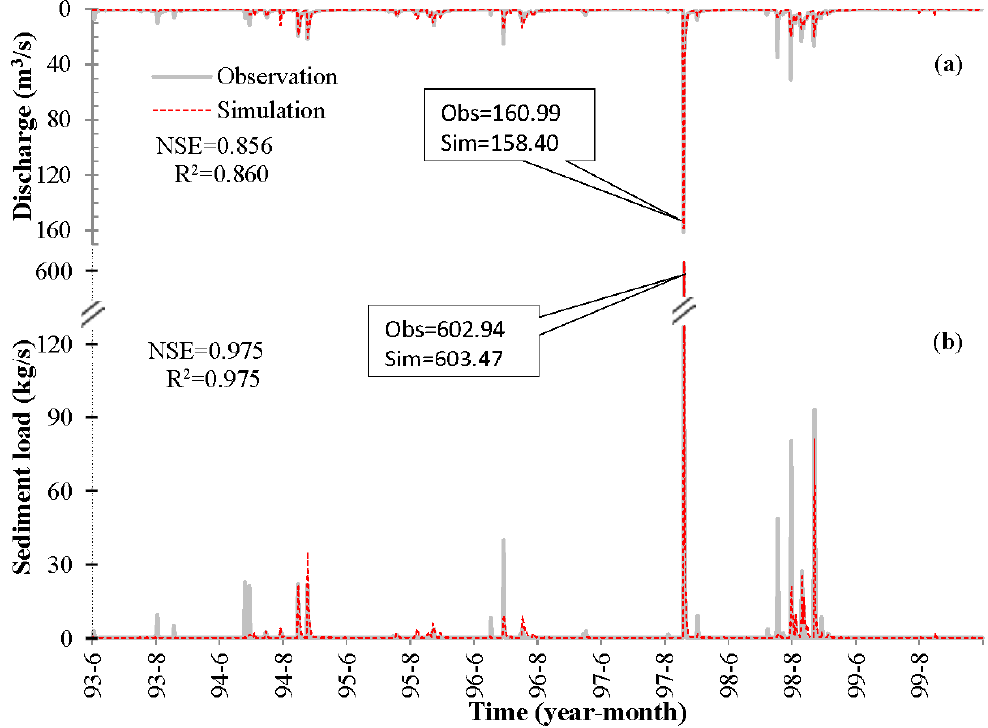
Figure 3. Optimal simulation results of the NSE approach during the flood season (from June to September) in 1993–1999: ( a ) comparison of the observed and simulated river discharges; and ( b ) comparison of the observed (black solid line) and simulated (red dot line) sediment loads.